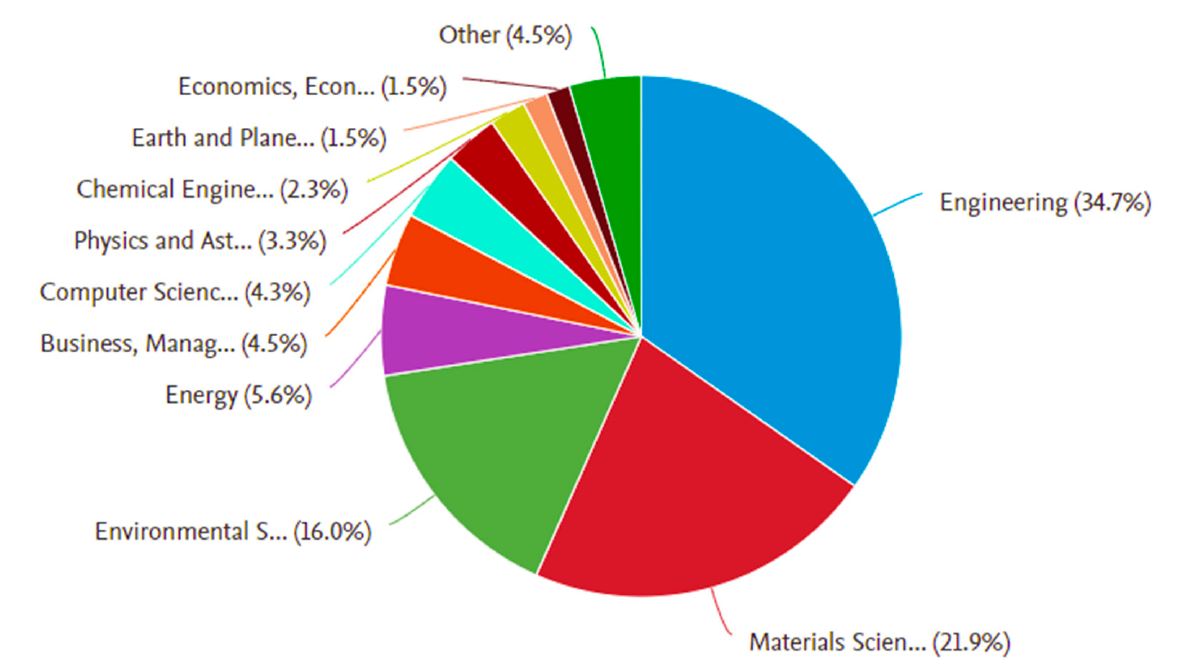
Figure 2. Subject area of articles.